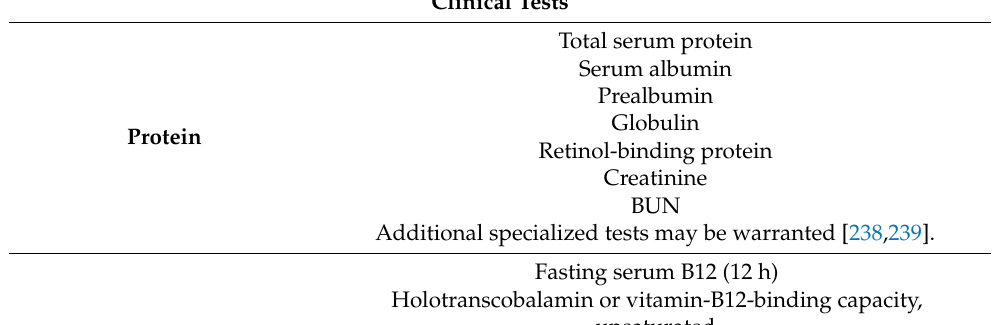
Serum ferritin Iron Total iron, iron-binding capacity, % saturation (calculated)